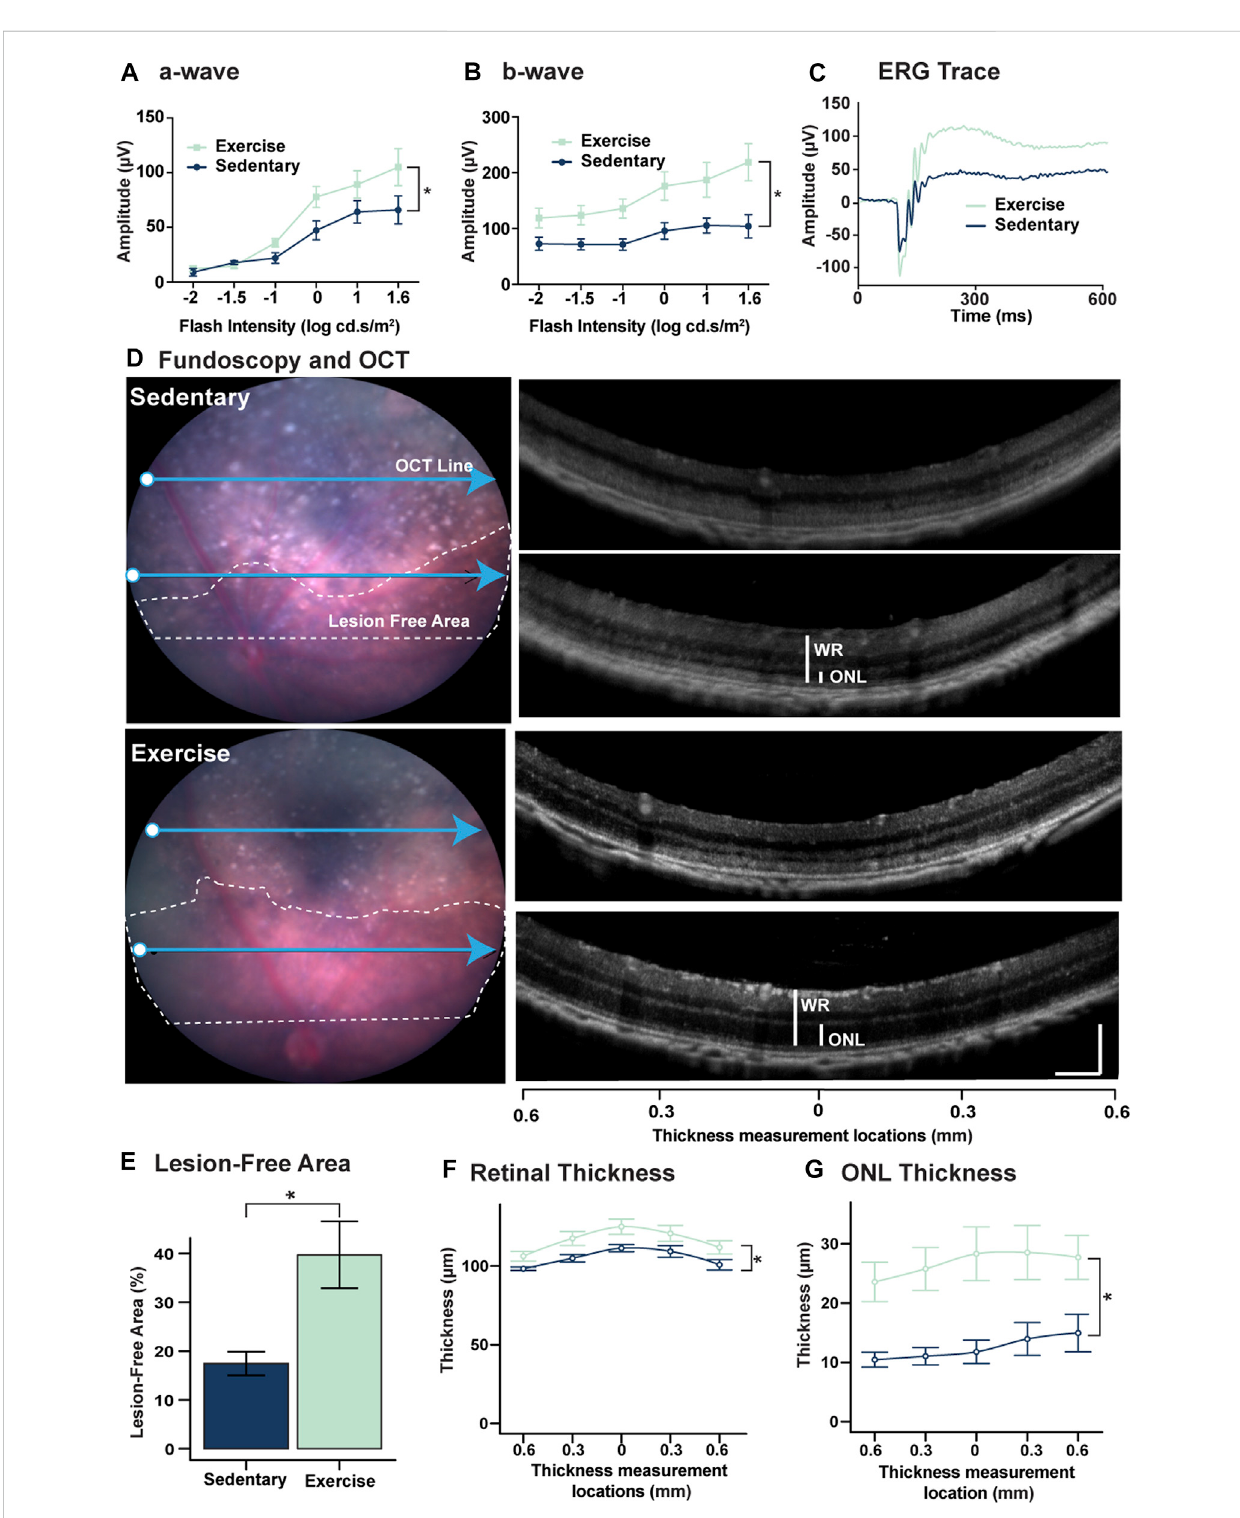
FIGURE 2 Voluntary exercise protects retinal function and morphology against degeneration. (A – C) Mice with access to voluntary exercise had signi fi cantly improved retinal function in both (A) a-wave, and (B) b-wave measures. (C) Representative ERG trace of exercised and sedentary mice using a fl ash intensity of 1.6log cd.s.m 2 . (D) Representative fundifrom exercise and sedentarymice. White dashed lines show retinal areas free ofsevere degeneration markedbythepresenceofhyper-re fl ectivepunctaandhyperpigmentation.BluearrowsshowthecorrespondinglocationoftheOCTretinasonthe right. (E) Quanti fi cation of lesion free areas expressed as a percent of the total retinal area superior to the optic nerve head. (F) Quanti fi cation of total retinal thickness and (G) ONL thickness. OCT images used for thickness measurements were captured at two-disc diameters superior to the optic nerve head measurements were taken directly above the optic nerve head and at 0.3 and 0.6 mm nasally and temporally. *Signi fi cance using two-way ANOVA with Sidak ’ s post hoc test for multiple comparisons, or Student ’ s t -test, p < 0.05 and error bars indicate SEM, n =